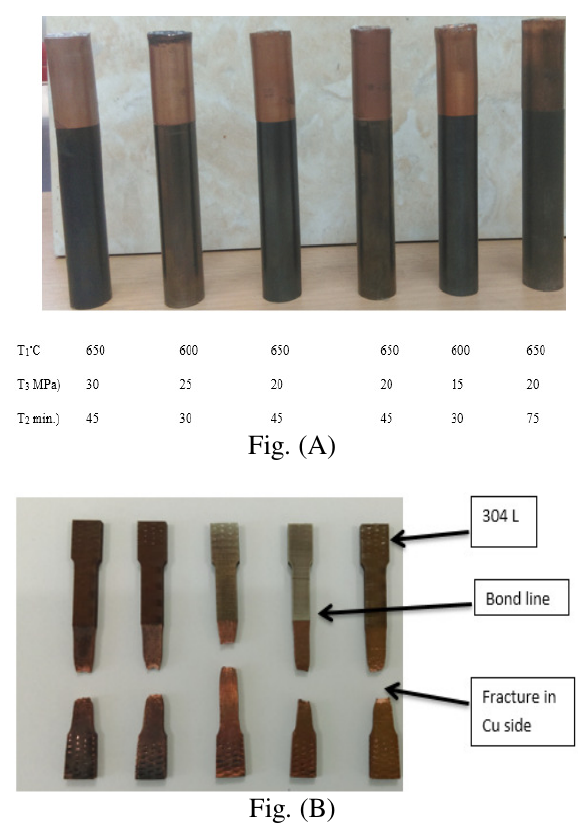
Fig. 3. (A) A set of diffusion bonding joints at different bonding conditions. ( B) Fracture of diffusion bonding